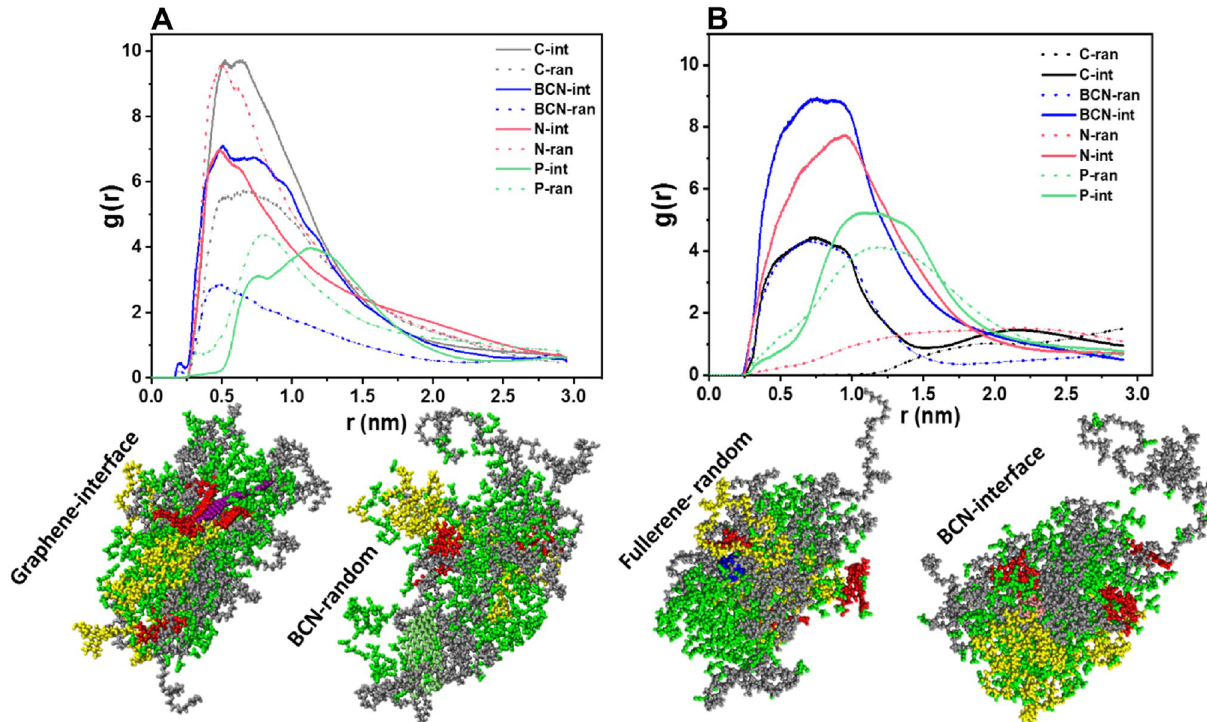
Figure 3. (A,B) Radial distribution function (RDF) of the center of mass of PNP in the individual simulations for graphene- and fullerene-based nanocarbon, respectively. In each subgroup, snapshots of the case with the highest and lowest values are